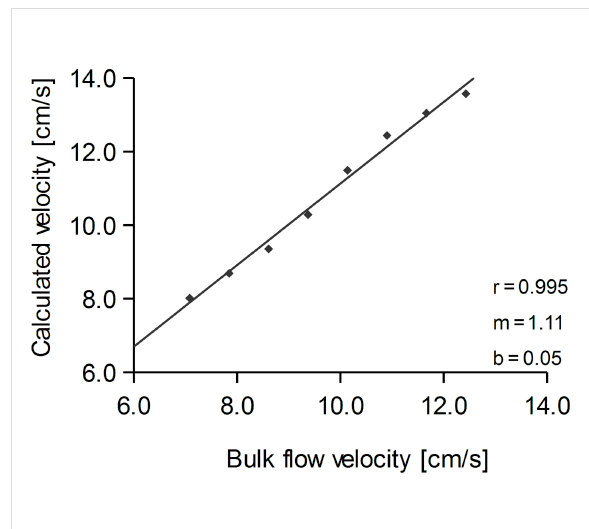
Figure 7: Velocity calculated with data obtained from AN 1 to AN 8 as function of bulk flow velocity. Note that the fitting curve intersects close to the origin (b = 0.05). Its slope (m) is larger than 1. This could be due to vibrations or a crosstalk between adjacent